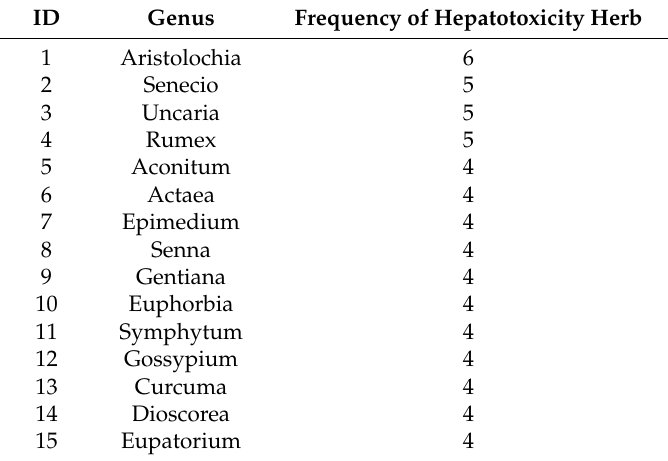
Table 3. The 15 genera containing hepatotoxic herbs greater than